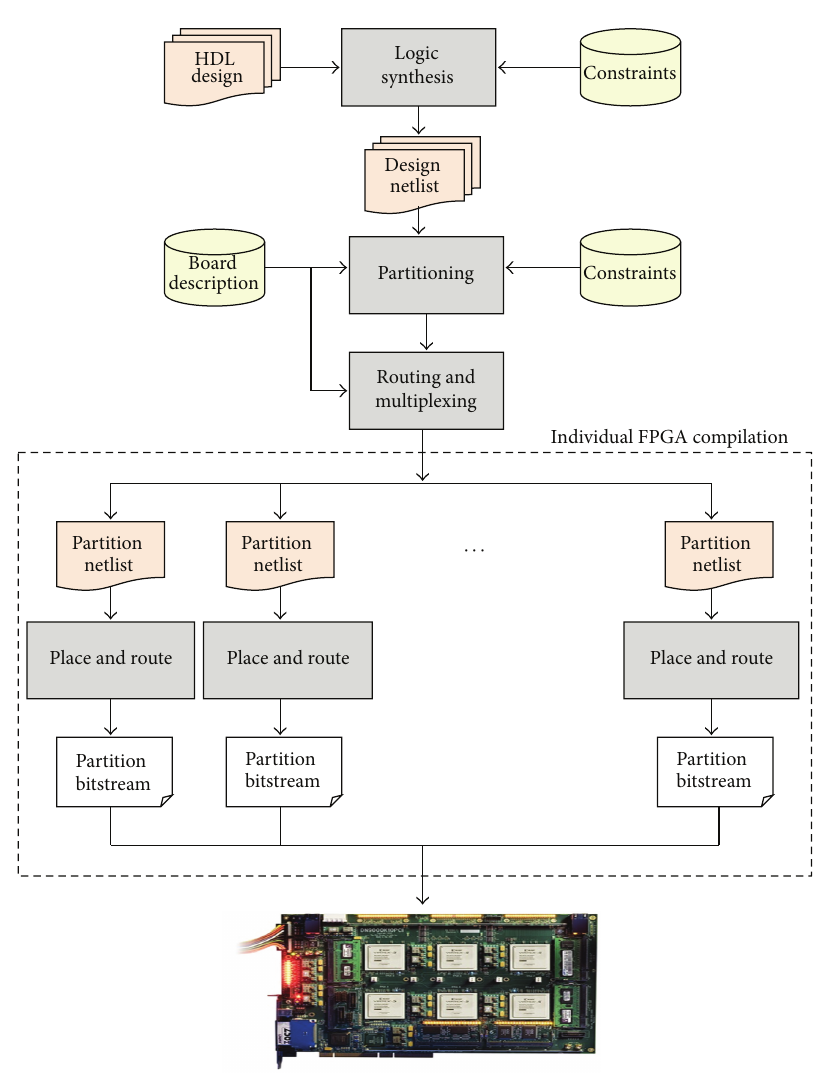
Figure 1: Prototyping